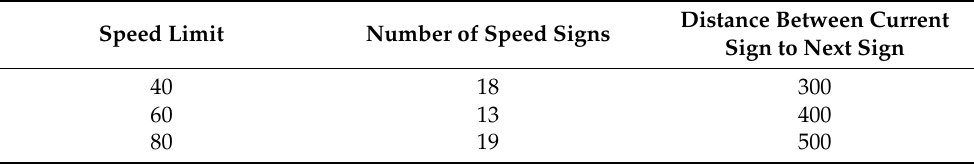
Figure 3. An illustration of the experiment design. Table 1. Unity driving simulator parameters quantifying speed signs and digital billboards.